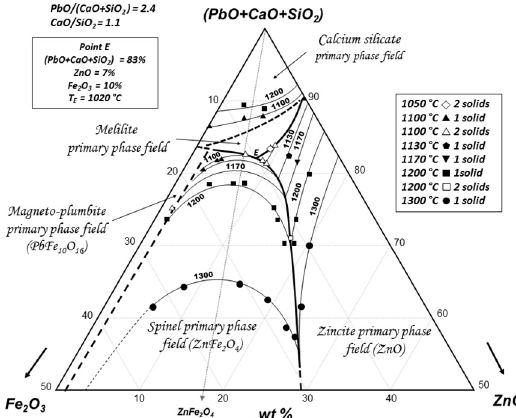
Figure 4. Experimentally determined liquidus surface on the pseudo- ternary section of “Fe O ”-ZnO-(PbO-CaO-SiO 2 3 SiO and PbO/(CaO+SiO ) weight ratios of 1.1 and 2.4, respectively. 2 2 CaO or SiO in solid solution, then the CaO/SiO 2 (CaO+SiO ) ratios in the liquid phase do not change. The 2